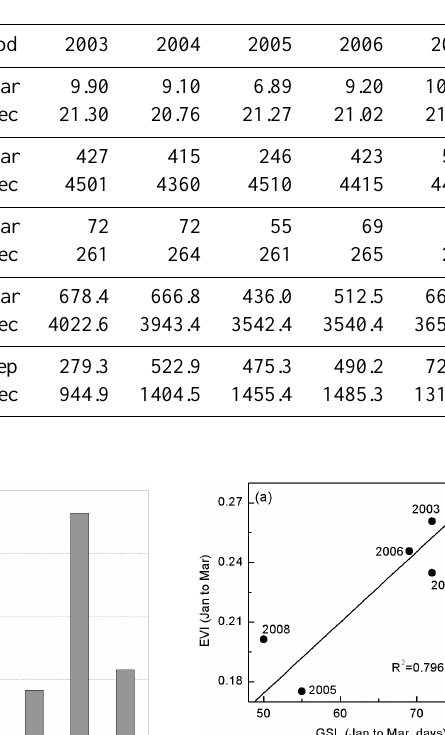
Table 1. Air temperature ( T a ) , accumulative T a ( T AC , ≥ 5 ◦ C), growing season length (GSL, T a ≥ 5 ◦ C, in days) and precipitation (PPT, mm) at QYZ site during 2003–2008.